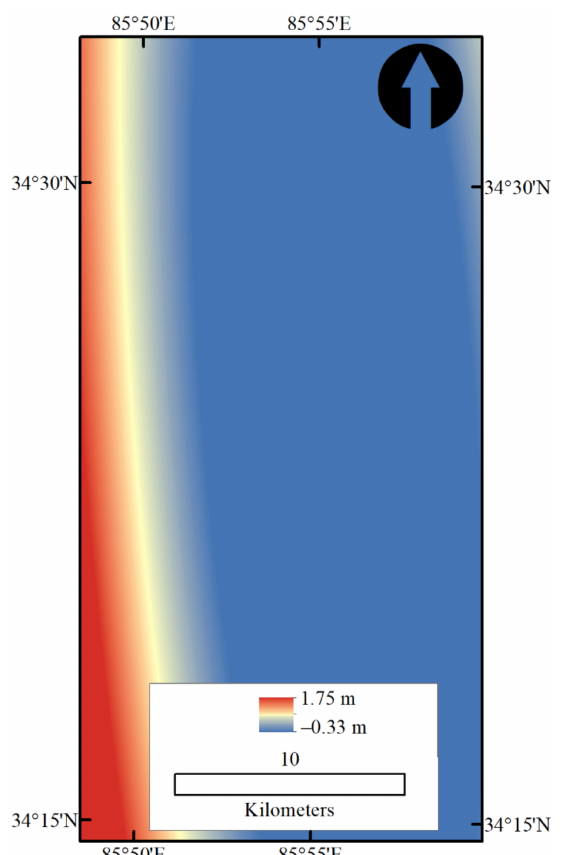
Remote Sens. 2021 , 13 , x FOR PEER REVIEW Figure A4. The surface trend in the difference map of HMA and SRTM after the co-registration.